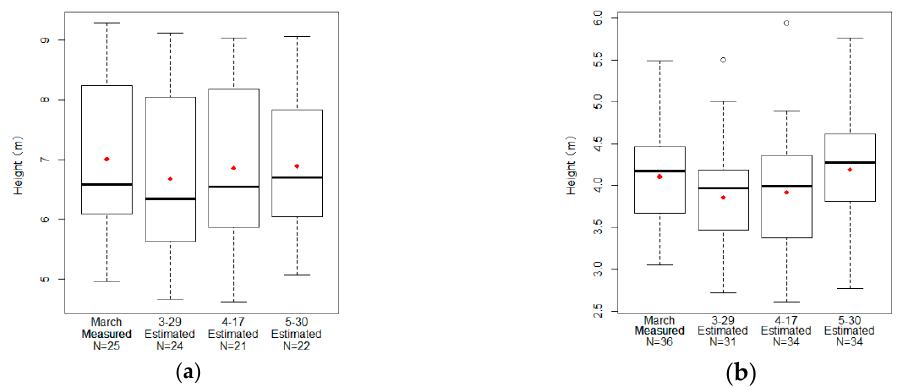
Figure 5. Box-and-whisker plot of the measured height and estimated height on the three dates for evergreen species AS ( a ) and OF ( b ). The red points indicate the tree height average; N is the sample size, which can be either the number of field-measured trees or the number of trees that were correctly detected from the photogrammetry point cloud.